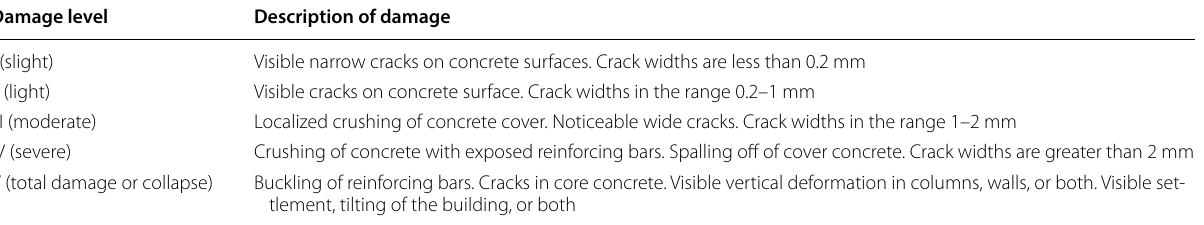
Table 1 Definition of damage levels of structural members, (JBDPA 2001).